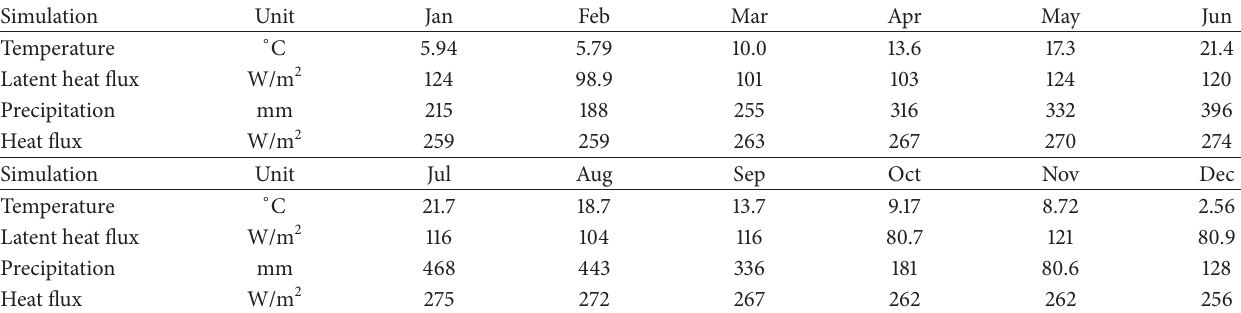
Table 3: Monthly projected values of climatic factors in Central Europe in